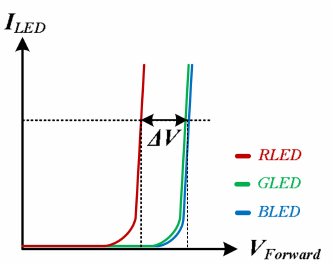
Figure 3. Different forward voltages of red-green-blue (RGB)LEDs under the same driving current.